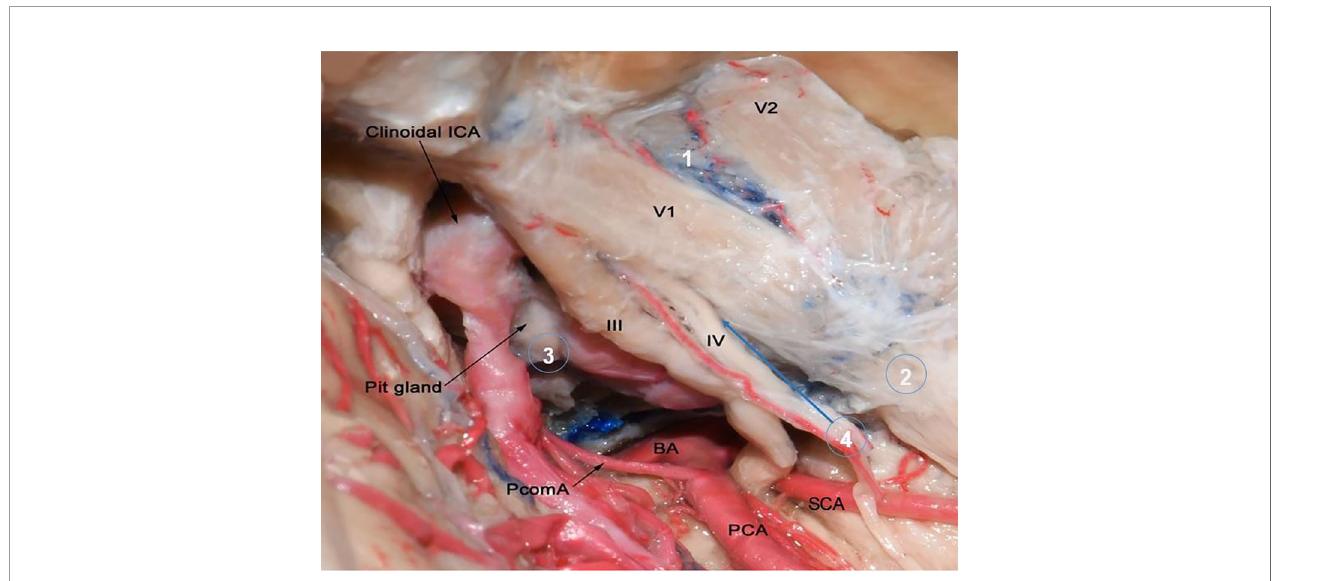
FIGURE 6 | Microscopic lateral view of right cavernous sinus to show the origin of most common tumors that involve the cavernous sinus. Circle number 1 is over the lateral wall of cavernous sinus which is the most common origin of CS meningiomas and they get their blood supply from MHT and ILT (not shown in this image). They account around 41% of all cavernous sinus tumors. Circle 2 is over trigeminal nerve which is the origin of schwannomas. Trigeminal schwannomas are the second most common cavernous sinus tumors and 49% originate in middle cranial fossa (19). They receive their blood supply from MHT and branches from external carotid artery. Circle 3 is over pituitary gland. Pituitary adenomas are the most common tumors that may extend into the cavernous sinus with an incidence of 10%. Their blood supply obtained from superior and inferior hypophyseal arteries. Circle 4 points to intracavernous sinus compartment. Cavernous hemangiomas are benign vascular tumors which are the most common primary intracavernous lesion. Metastasis is also may be seen in intracavernous compartment. Tumors originating from intracavernous compartment may get their blood supply from all intracavernous ICA branches. BA, Basilar Artery; ICA, Internal Cerebral Artery; PCA, Posterior Cerebral Artery; PcomA, Posterior Communicating Artery; Pit, Pituitary; SCA, Superior Cerebellar